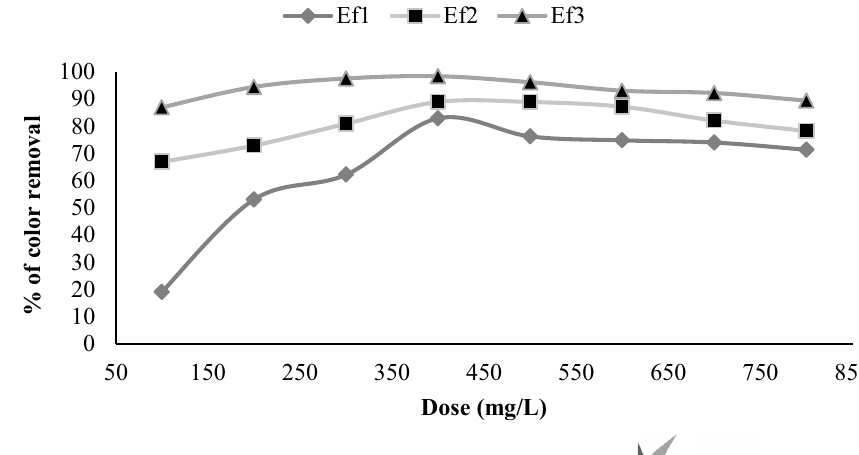
Fig. 2 Effect of coagulant doses on the color removal efficiency of the effluents (pH = 7.0, agita- tion speed 60 rpm and tempera- ture 30 °C for PAC